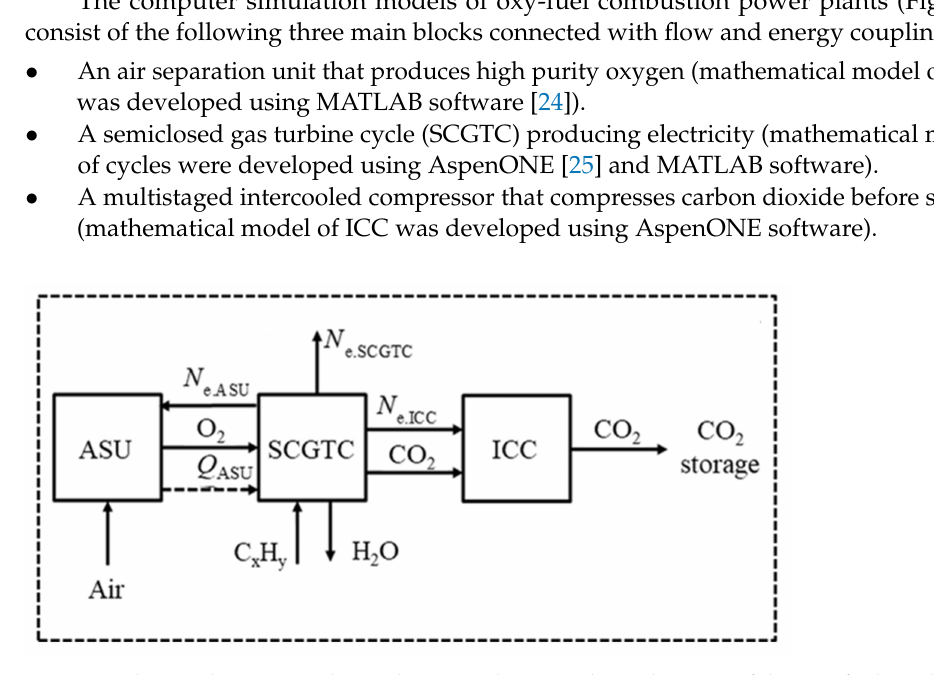
Figure 4. Flow and energy exchange between the main three elements of the oxy-fuel combustion power